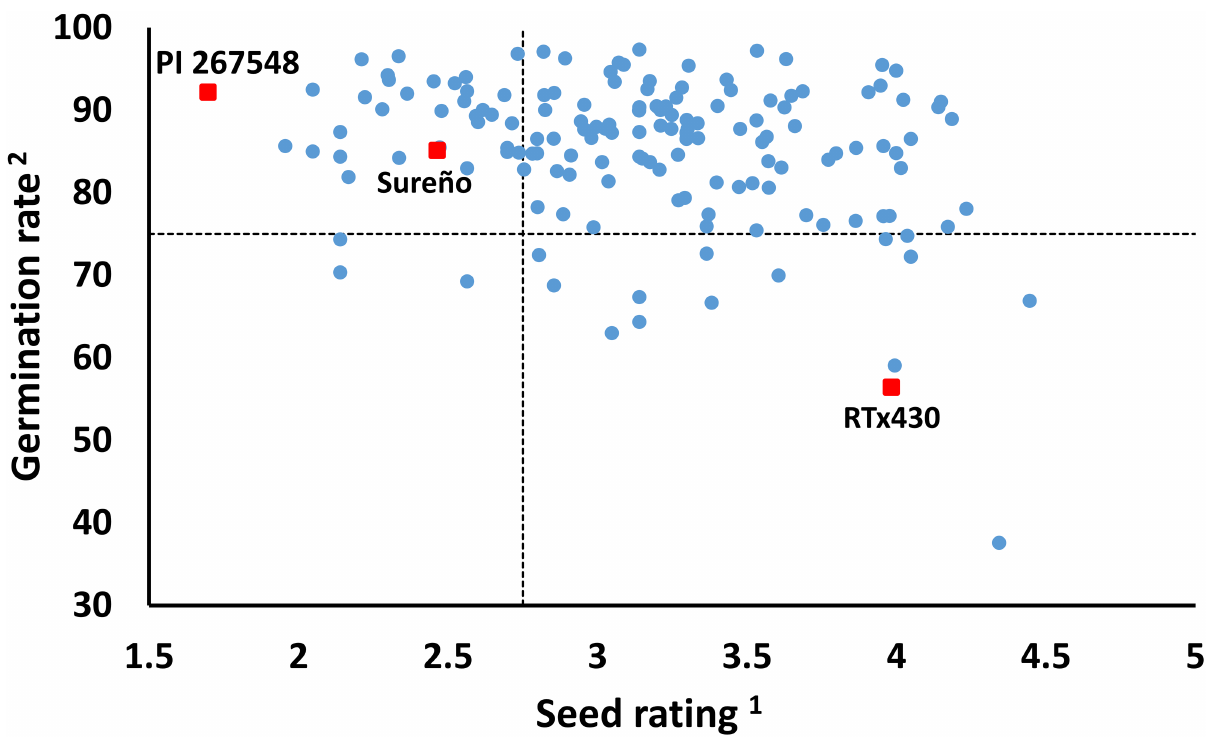
Fig 4. Seed quality distribution of 158 NPGS Senegal sorghum accessions and three references lines. Seed quality evaluations were completed at Isabela and Mayaguez, Puerto Rico, during the fall of 2014. Dashed lines indicate Tukey-Kramer HSD significant differences ( p < .05) from PI 267548. 1 Seed mold rating based on a scale of 1–5 where 1–2 are resistant and 3–5 are susceptible. 2 Germination rate based on the percent of seeds that germinated after 10 days in flats containing Metro Mix 200 potting medium.